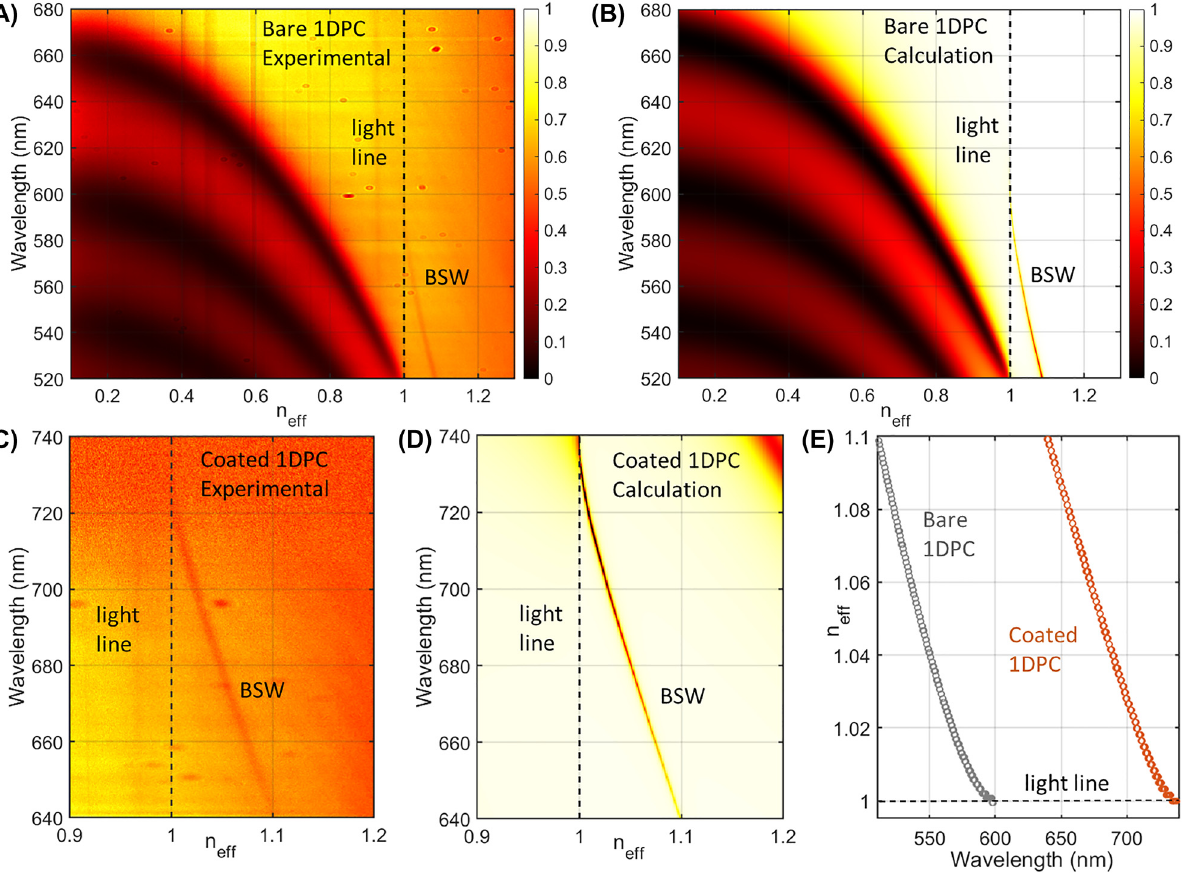
Figure 2: BSW dispersion curves. (A) Measured and (B) calculated angular-resolved spectral reflectivity map of the bare 1DPC; (C) measured and (D) calculated reflectivity maps for the coated 1DPC, where the coating is a 65 nm – thick DR1M-PPA layer with refractive index n estimated from fitting the experimental data. Note that the halogen lamp spectrum is reaching almost zero intensity at wavelengths above 720 nm. (E) Calculated BSW dispersions for bare and coated